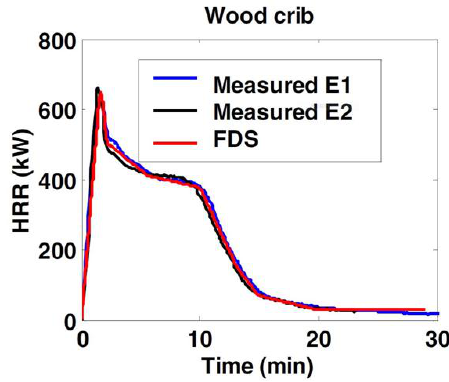
Figure 3. Heat release rate curve of wood model [40]. Table 3. Scenario description in the different simulation cases.